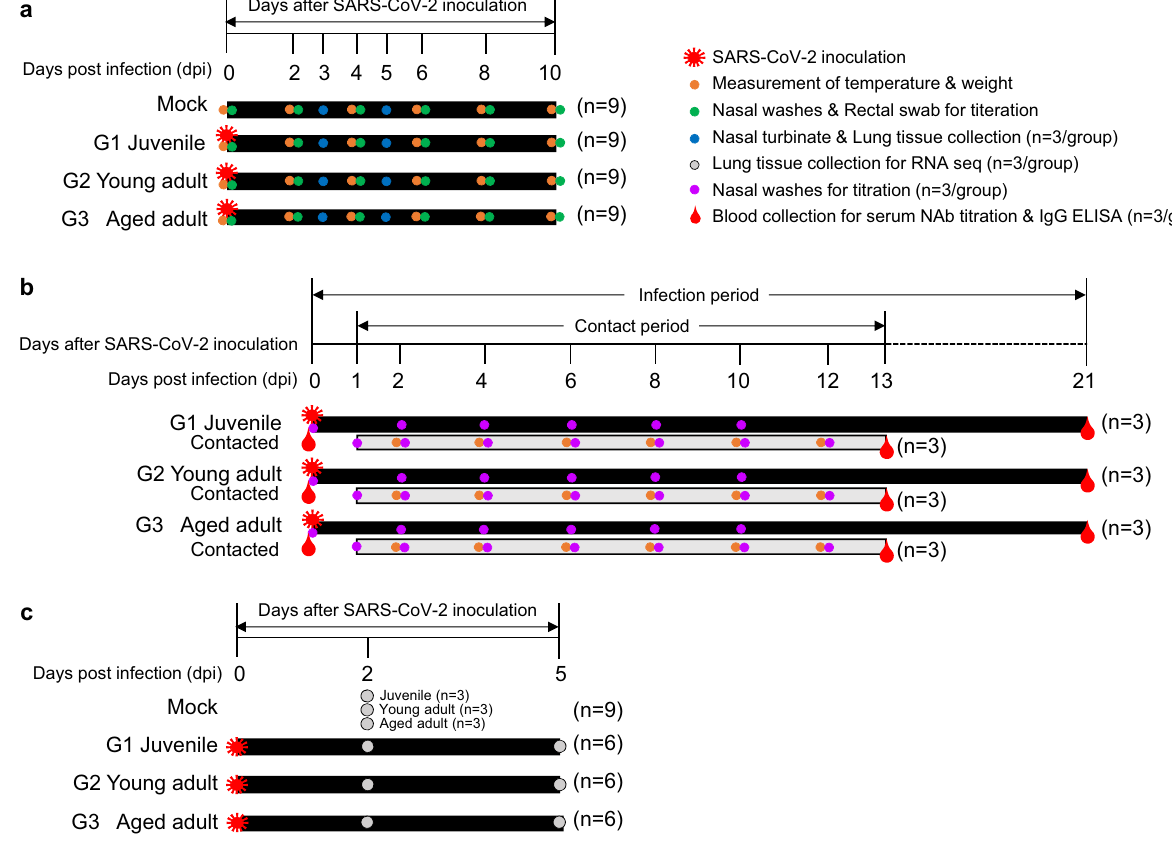
Fig. 1 Schematic diagrams illustrating ferret study design. Experimental layout of age-dependent pathogenesis of SARS-CoV-2 in ferret animal model. a Timetable showing time points of virus inoculation, observation and monitoring of clinical manifestation and sample collection in infected ferrets by age groups. Orange circle denotes for time points of temperature and weight measurement, green circle for nasal washes and rectal swab sample collection, and blue circle indicates nasal turbinate and lung tissue harvest for viral titration. b Timetable for ferret-to-ferret transmission study and blood sample collection for serum neutralizing and IgG antibody titration: at 24 h post-infection of the infected ferret groups, 12 – 24 month-old naive ferrets ( n = 3/ group) were introduced in direct contact with infected ferrets and was co-housed with each group of infected ferrets in the same cage up to 12 days. Several time points are indicated for monitoring and sample collection. Orange circle denotes time point for temperature and body weight measurement, while purple circle indicates points for collection of nasal washes for viral titration. Red water drop shape indicates euthanasia after whole blood collection. c Timetable for RNA-seq analysis: groups of ferrets ( n = 6/group) were SARS-CoV-2 inoculated at 0 dpi with exception to the mock infection group. PBS- treated ferrets ( n = 9) were intranasally inoculated with phosphate-buffered saline (PBS) for the mock-infection group. Ferrets of the same ages as the test groups ( n = 9 (Juvenile = 3, young adult = 3, aged = 3)) were then euthanized at 2 dpi, and lungs were harvested for RNA-seq analysis. SARS-CoV-2 infected ferrets by age ( n = 3/group) were euthanized at 2 dpi and 5 dpi respectively, and lungs were harvested for RNA-seq